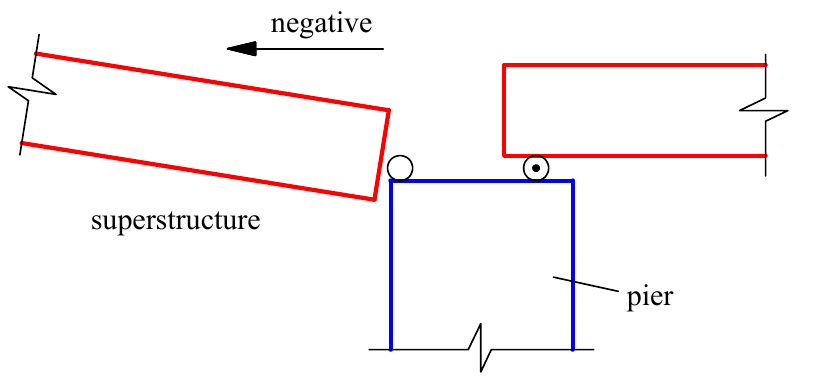
Figure 9. Schematic of deck unseating. Absolute values in all cases are less than the limit value, as shown in Figure 10. Maximum bearing (B2) displacement for negative direction presents nearly the same value with the stopper value, except the case of D2000. The stiffness and resistance force of viscous damper are insufficiently large to resist the structure movements. Thus, the stopper prevents the superstructure movements. As the stopper value increases, maximum bearing (B2) displacement for negative direction increases. Maximum bearing (B2) displacement in the case of D2000 also presents a least value. The resistance force and stiffness of D2000 are the largest amongst all the selected viscous dampers. Thus, the movement of roller bearing (B2) is relatively hard compared with other viscous dampers, which leads to the least